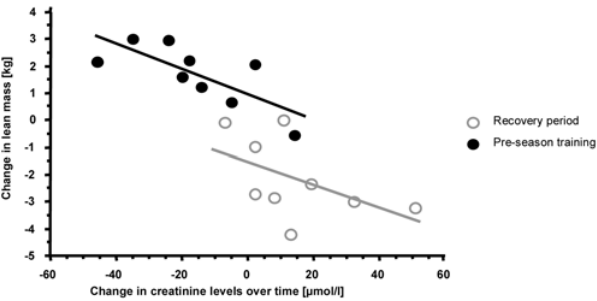
Figure 2. A significant inverse correlation was found between the total lean mass and increased/decreased levels of creati- nine over the time period from the end of playing season to the end of recovery, as well as from recovery to the end of pre- season training.